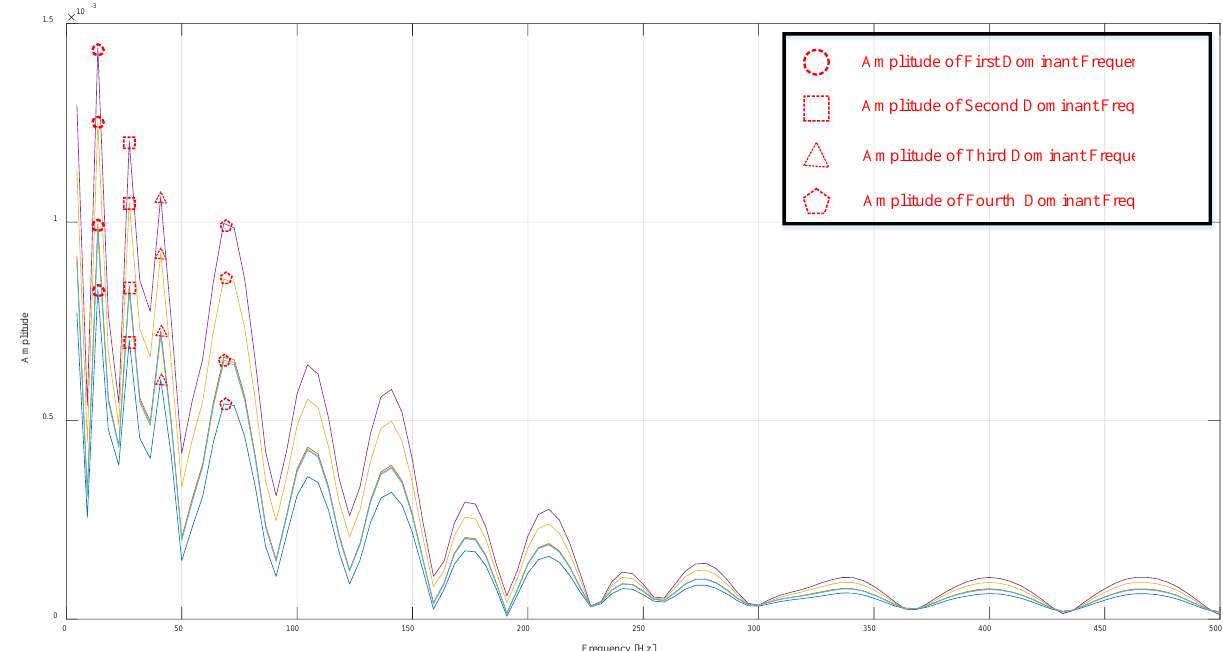
Figure 3. Frequency domain signal and extracted characteristics.